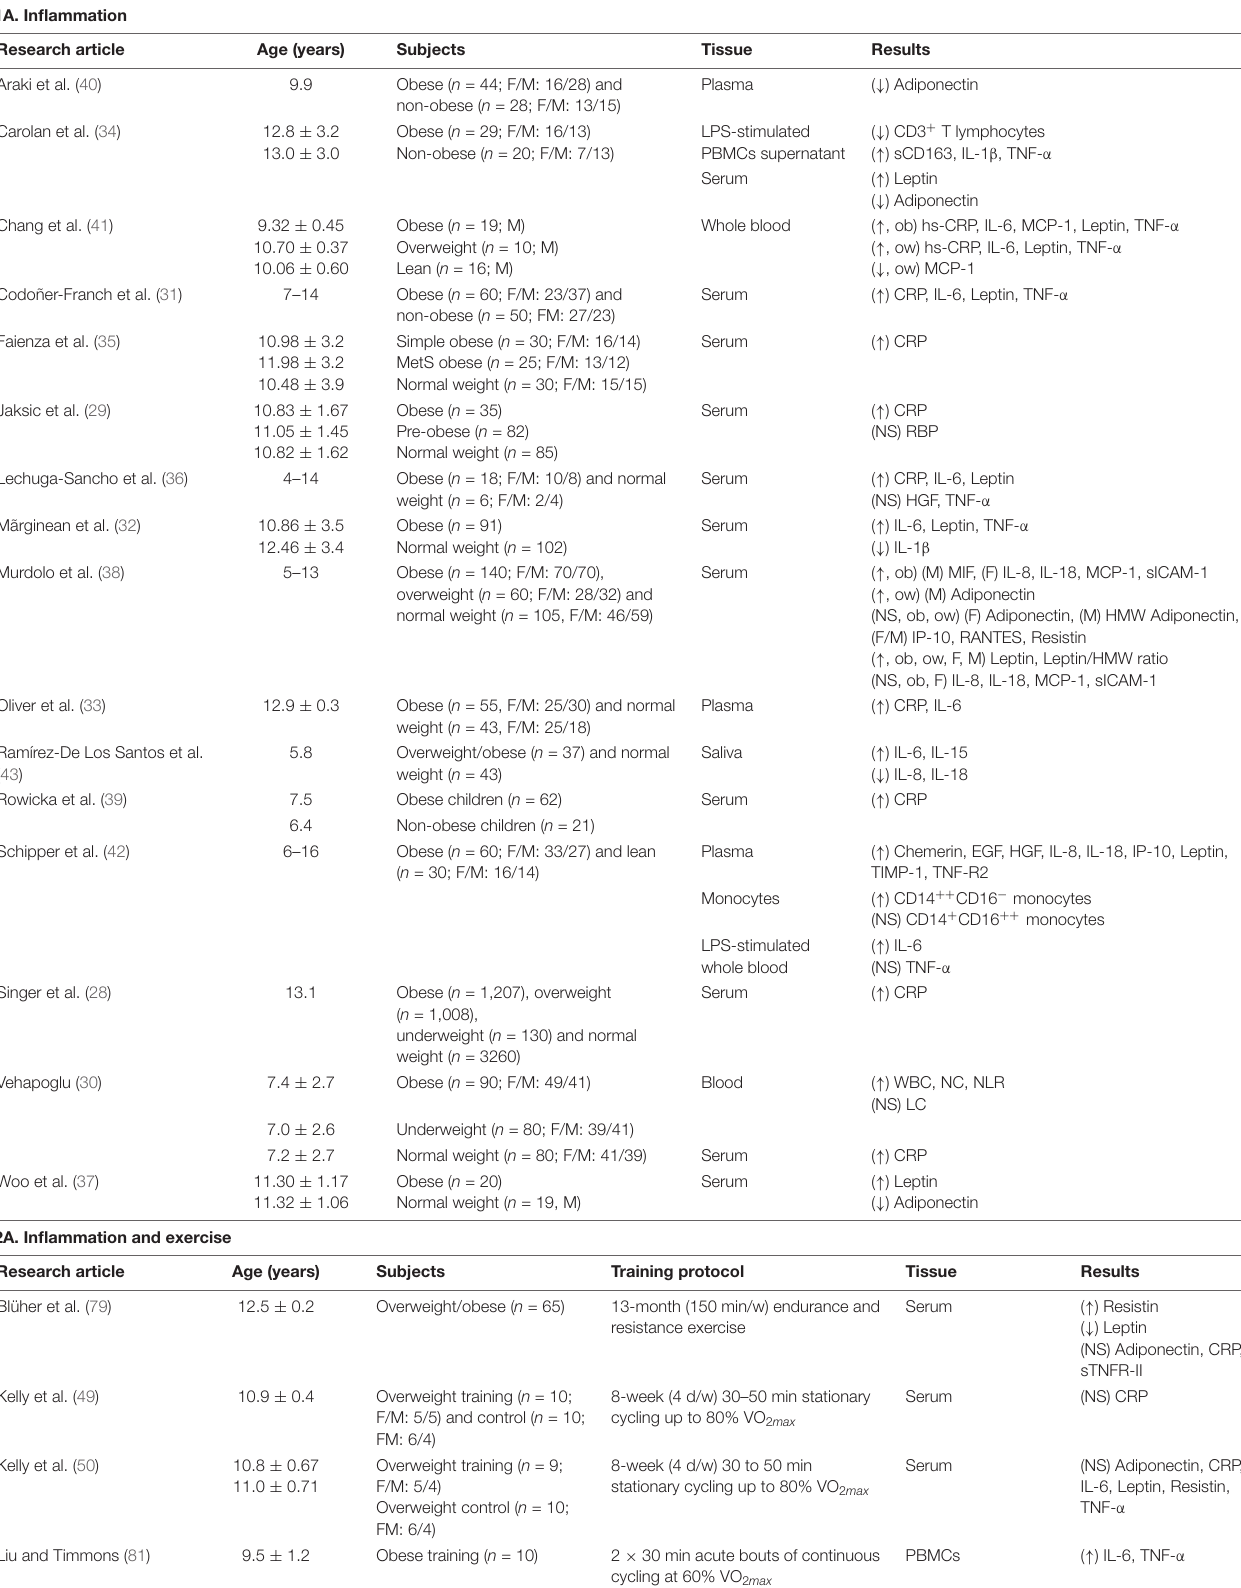
TABLE 1 | Effects of childhood obesity (1) and exercise (2) in obese children on inflammation (A) and oxidative stress (B)